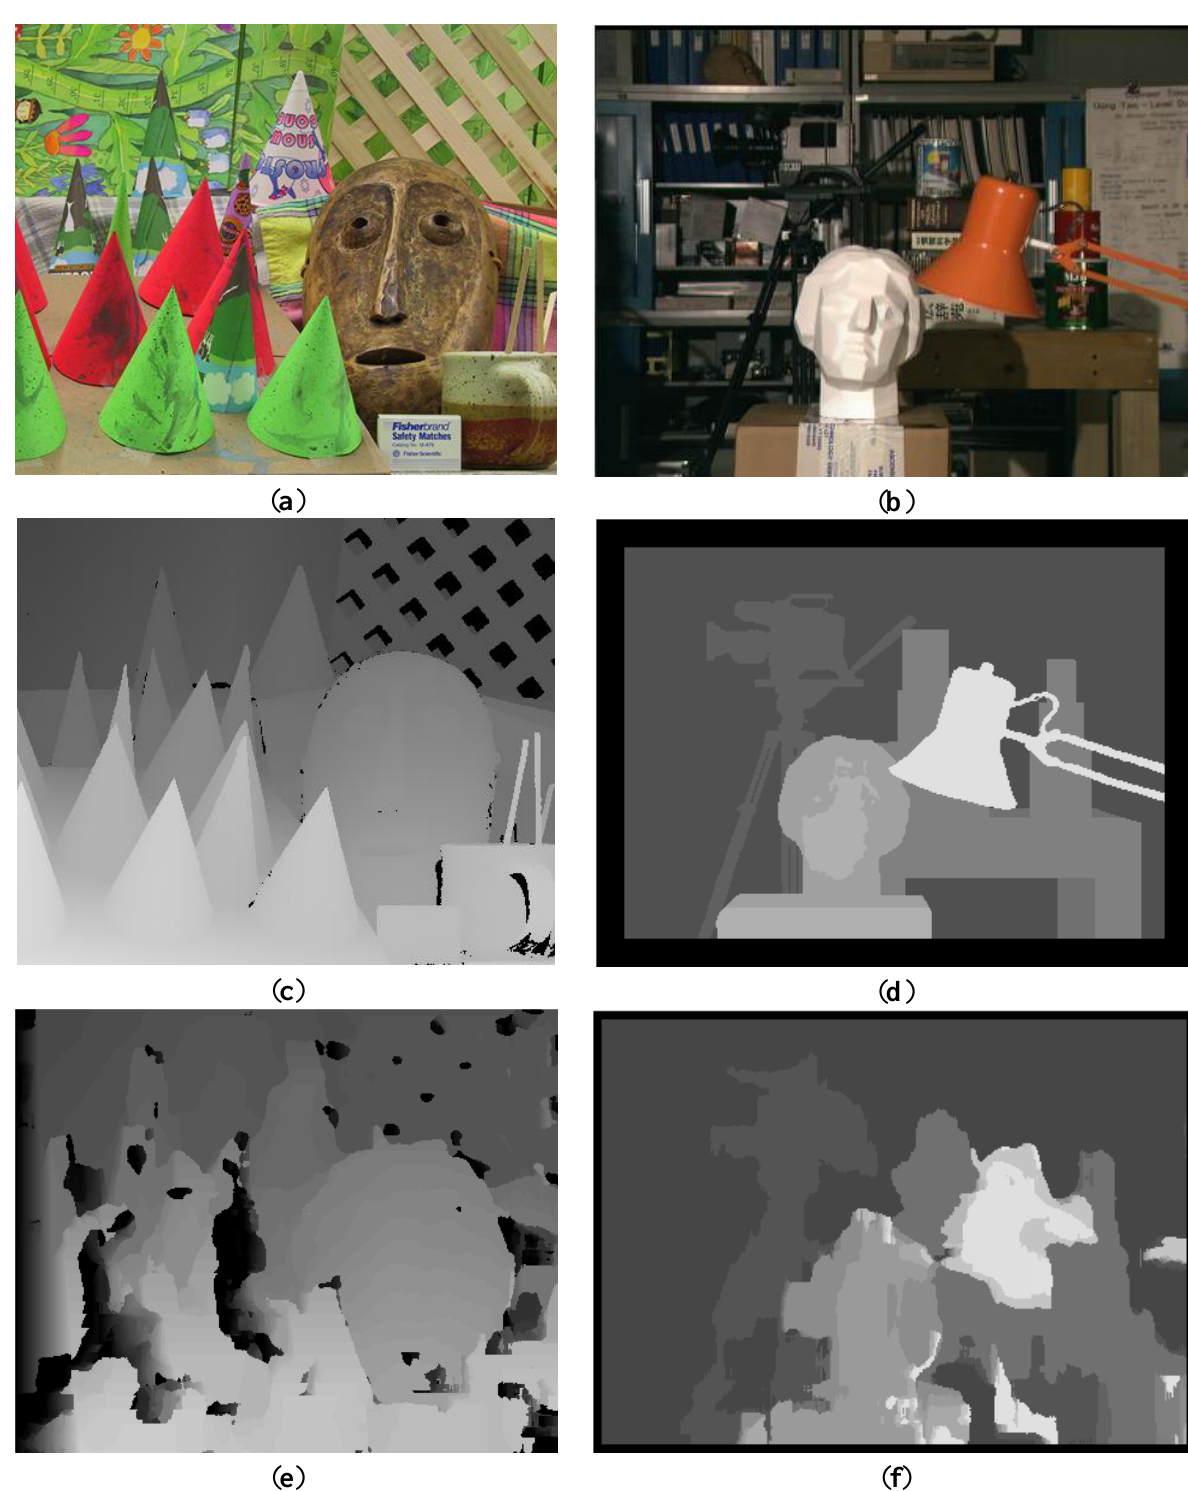
Figure 17. Correlation results: ( a ) Original Cones dataset. ( b ) Original Tsukuba dataset. ( c ) and ( d ) Ground truth. ( e ) and ( f ) Correlation